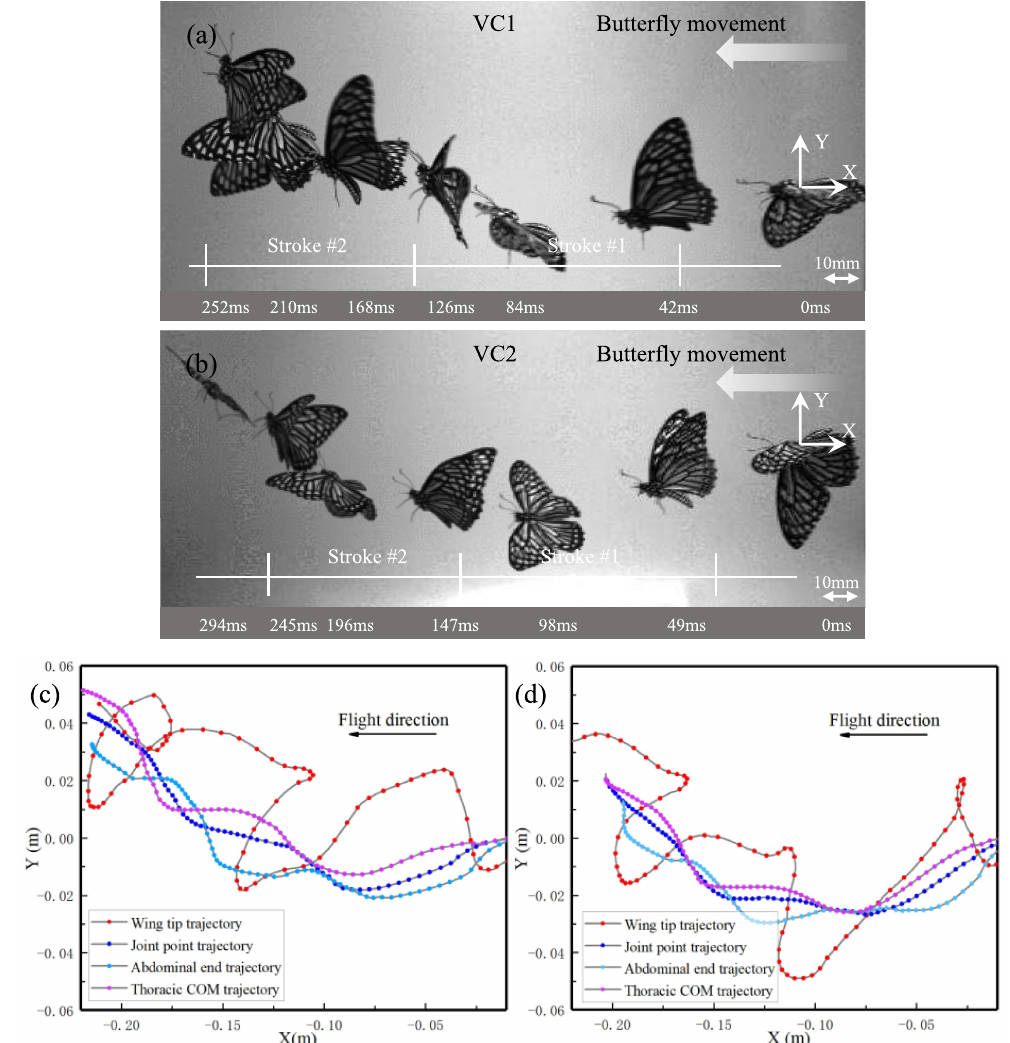
Figure 4. Snapshots from the front-view camera of a butterfly in forward flight: VC1 ( a ); and VC2 ( b ). Trajectories of the butterfly feature points in the upward direction (along the Y -axis) and the forward direction (along the X -axis) during forward flight: VC1 ( c ); and VC2 ( d